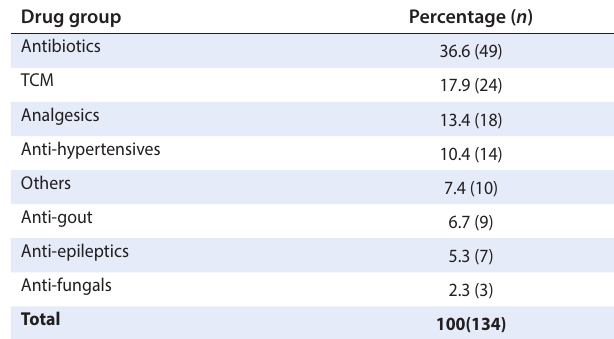
Table 4: Common drugs responsible for